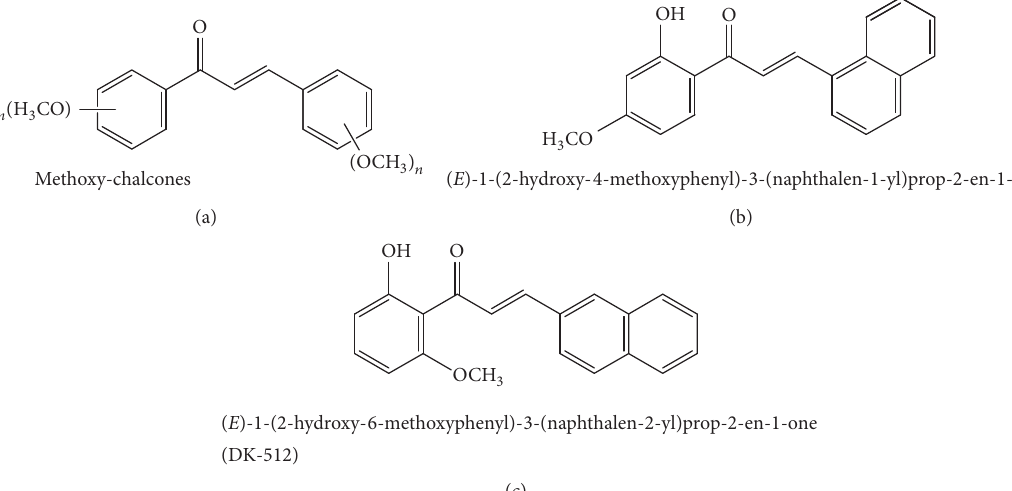
Figure 1: The structures of methoxy-chalcone (a), hydroxy-methoxy-benzochalcone (b), and ( E )-1-(2-hydroxy-6-methoxyphenyl)-3- (naphthalen-2-yl)prop-2-en-1-one (c).